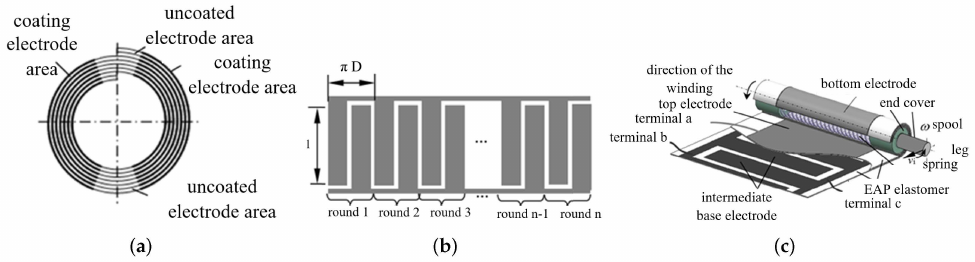
Figure 3. Electrode shape of the cell and winding process, where ( a ) is electrode division, ( b ) is comb-shaped electrode, and ( c ) is winding